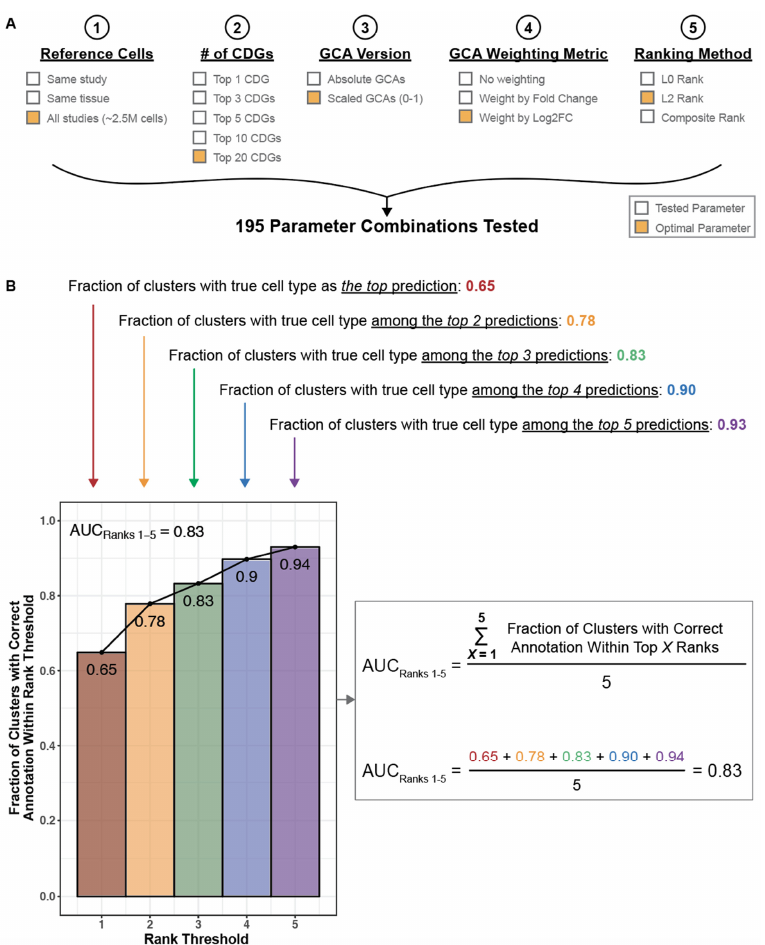
Figure 3 . Hyperparameters tested for cluster annotation and schematic of algorithm performance evaluation. ( A ) Hyperparameters tested for each step of the cluster annotation algorithm, as described in Figure 2. The parameters that yielded optimal annotation performance are highlighted in orange. To compute CDGs, we compared the mean expression of all genes in the cluster of interest to their mean expression in a set of reference cells. Reference cells were taken as all other cells from the corresponding study (“within study”), all other cells from the corresponding tissue (“within tissue”), or all other cells from all processed studies (“pan-study”). After computing fold change values for each gene, we tested the selection of 1, 3, 5, 10, or 20 genes for the downstream annotation steps. We tested the use of absolute and scaled versions of GCAs (local scores between genes and cell types). To compute L2 norms, we tested the weighting of each GCA term with the corresponding fold change and log 2 FC values to increase the contribution of the strongest CDGs to the cell type prediction. To rank all candidate cell types, we considered a modified L0 norm (number of genes with GCA > 3 to the given cell type), an L2 norm, and a composite metric that considers both the modified L0 and L2 norms. ( B ) For each parameter combination ( n = 195), a cumulative distribution plot was generated to illustrate the fraction of clusters which were correctly predicted within a given rank, ranging from rank 1 to rank 5. To summarize the performance, we considered the number of clusters which were annotated correctly (corresponding to the red bar at Rank Threshold = 1), and we estimated the area under this curve (denoted as AUC Ranks 1–5 ) as the average fraction of clusters for which the correct annotation was present among the top 1, 2, 3, 4, and 5